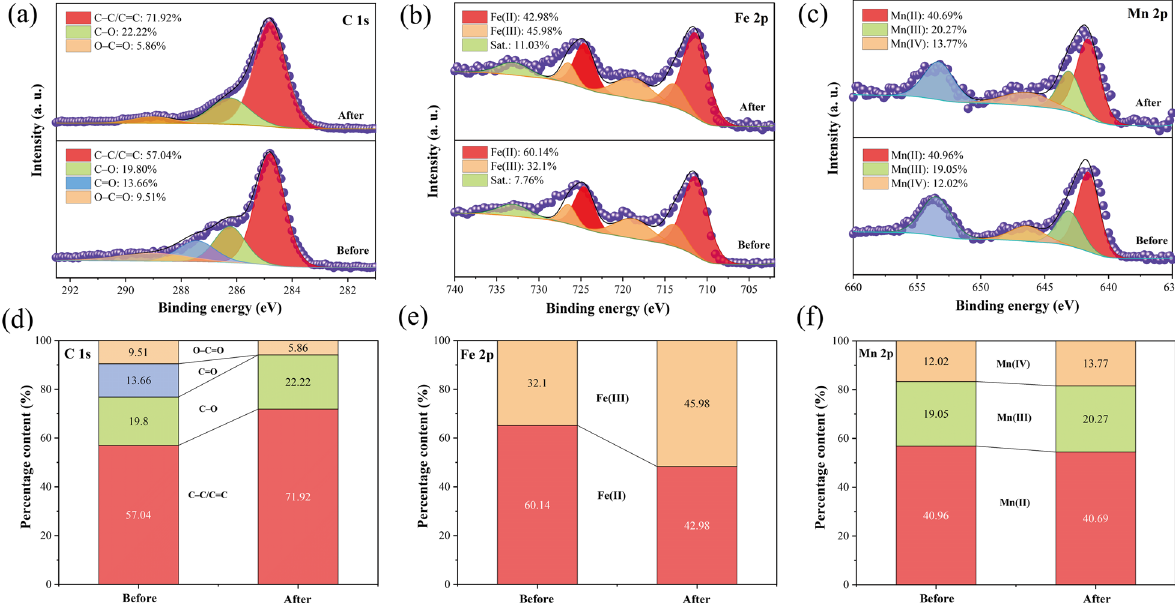
Fig. 4 Effects of different quenchers on p -ASA degradation ( a ), and the corresponding changes of reaction rate constants ( b ). Reaction condi- tions: MFB = 1.0 g/L, PS = 2.1 mM, MeOH = 2.1 M, BQ = 1 mM, l -Histidine = 10 mM, pH = 7.0, T = 298 K